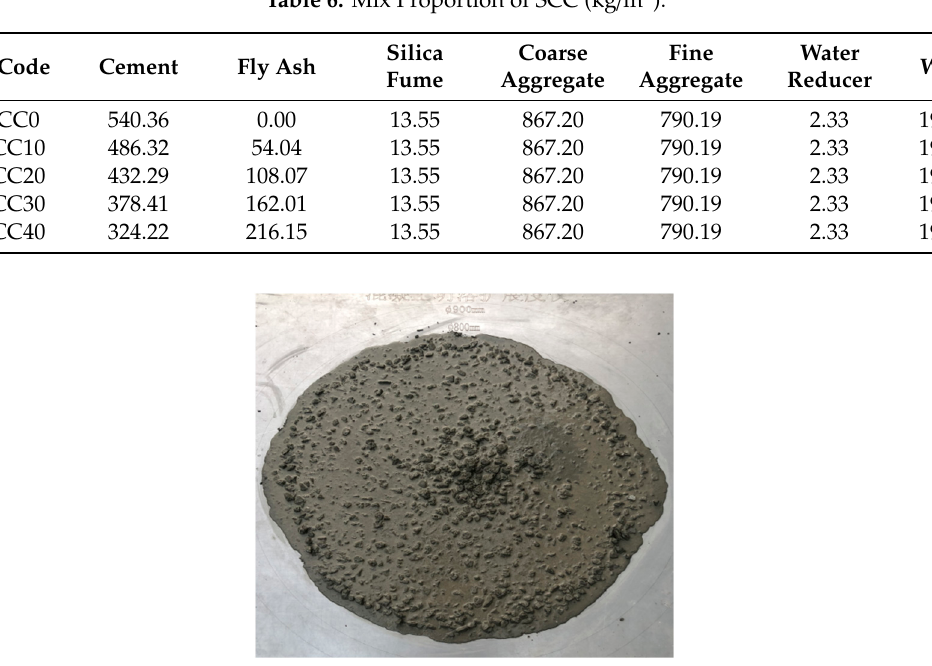
Table 6. Mix Proportion of SCC (kg/m 3 ).